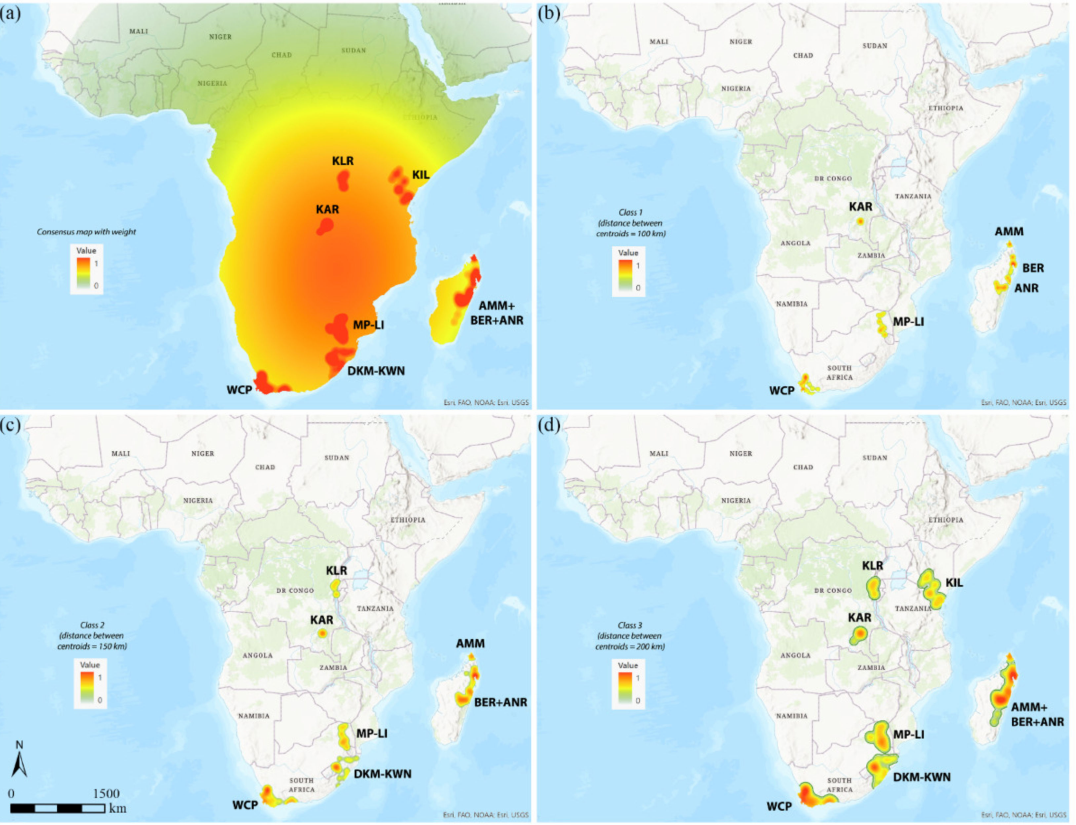
Figure 3. ( a ) Consensus maps of the areas of endemism detected by GIE. ( b ) Areas of endemism detected by GIE in Class 1 (100 km), ( c ) Class 2 (150 km) and ( d ) Class 3 (200 km). As the intrinsic value of an endemic species is weighted by the width of its distribution range, the kernel maps of the three classes selected (Class 1, Class 2, Class3) are